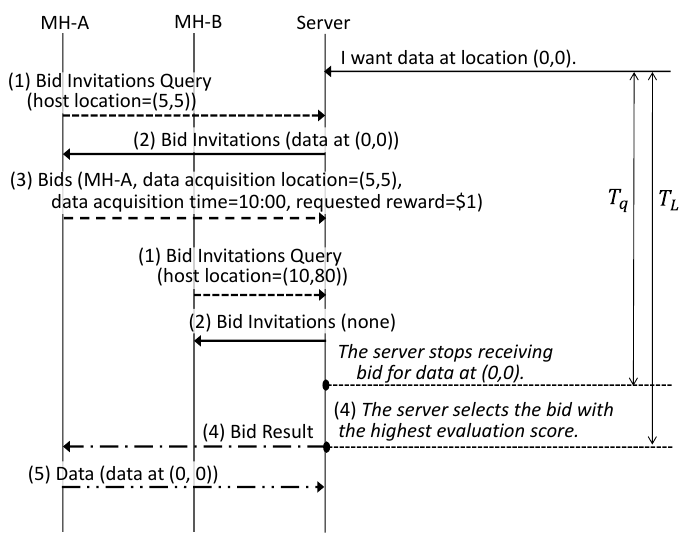
Figure 3. Example of the bidding sequence of the existing method.